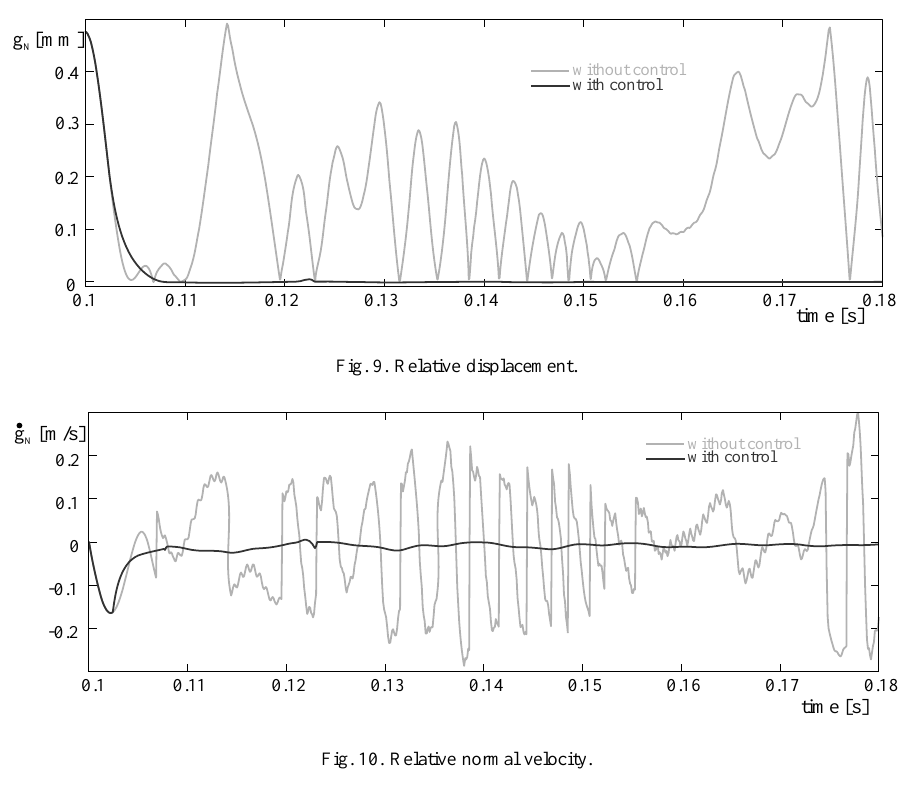
Fig. 9. Relative displacement.